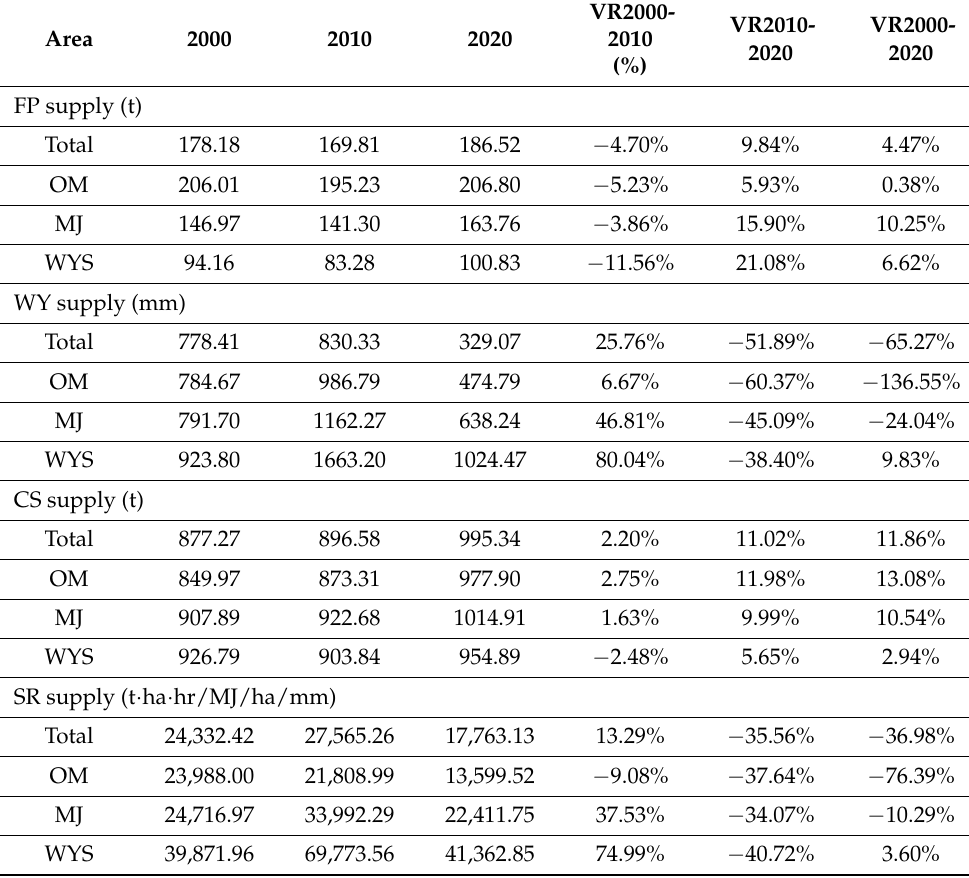
Table 3. The ecosystem services supply mean values in different areas and their variation